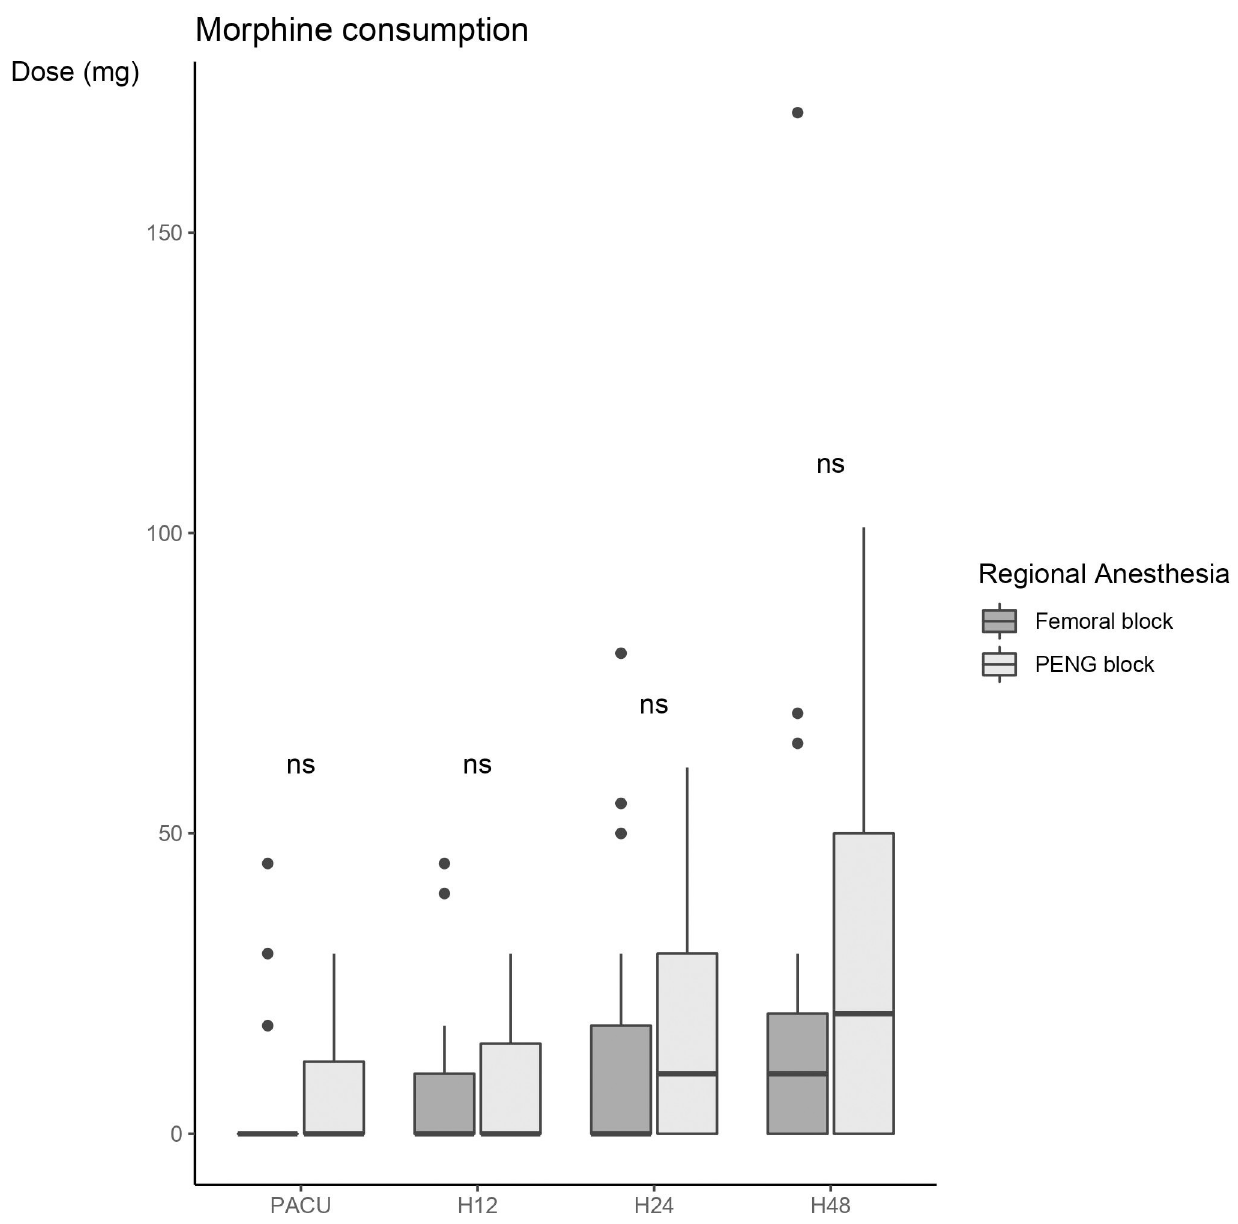
Fig 3. Morphine consumption at different times: Before leaving the RR, 12 hours postoperatively (H12), 24 hours postoperatively (H24) and 48 hours postoperatively (H48). Explanation of the figure: Box-plot diagram: The rectangle extends from the first quartile to the third quartile and is intersected by the median. The segments at the ends of the rectangle provide information on the extreme values.